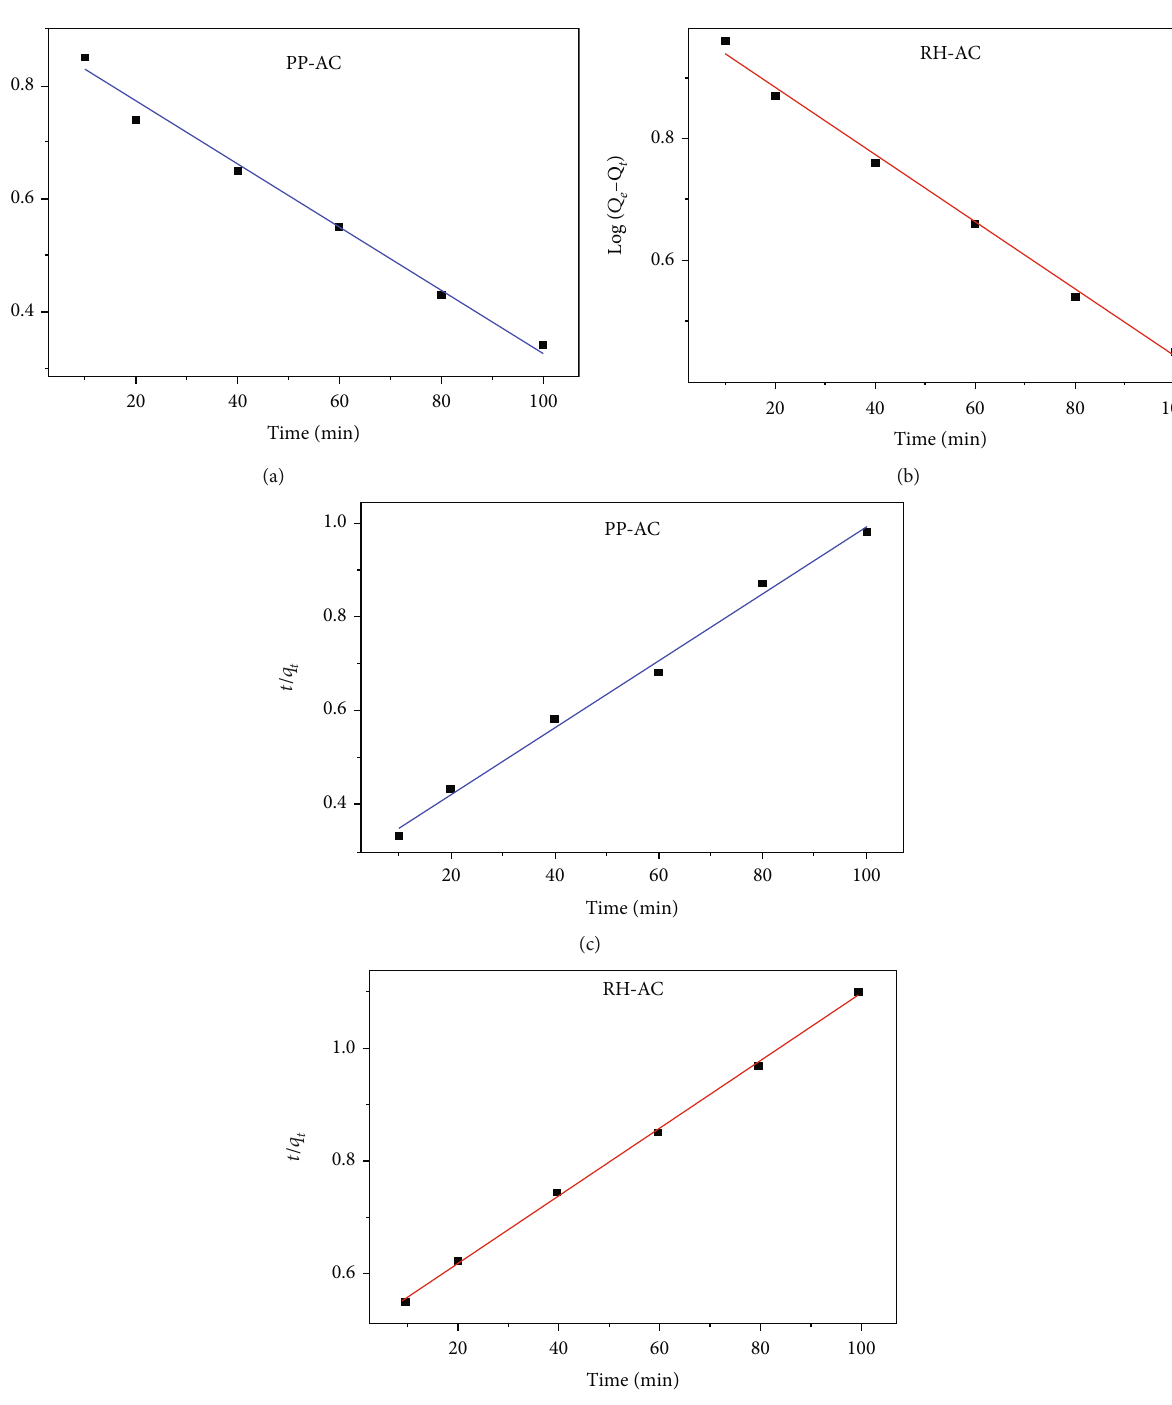
Figure 6: The plot of (a, b) pseudo fi rst-order and (c, d)